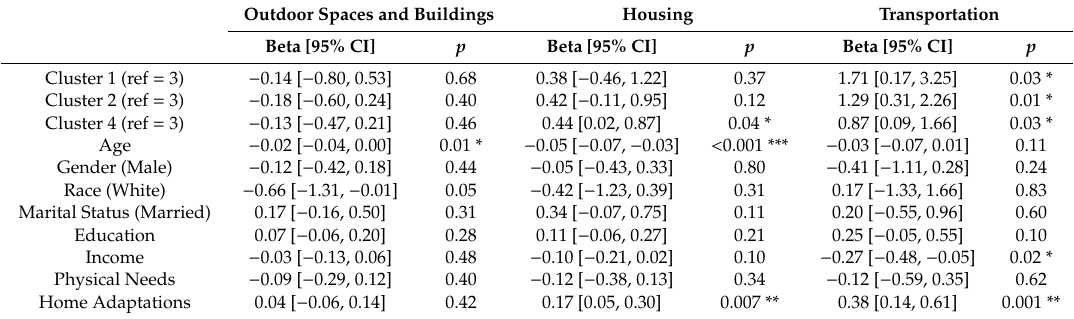
Table 2. Linear regression comparing Clusters 1, 2, and 4 to Cluster 3 on outdoor spaces and buildings, housing, and transportation after controlling for functional capacity and